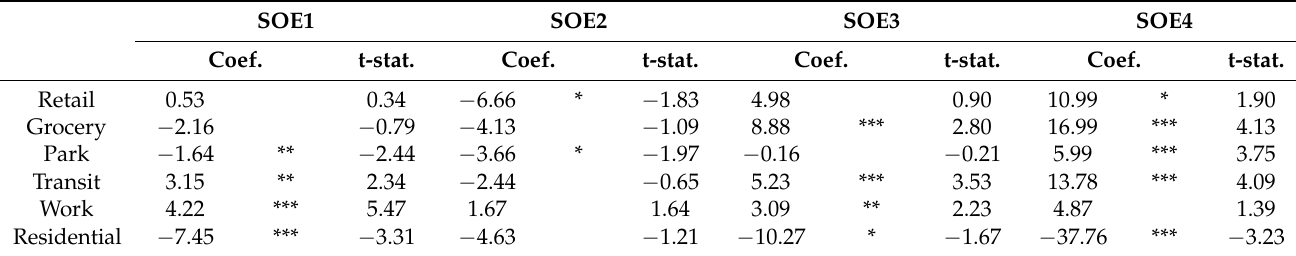
Table 7. ARDL long-term coefficient